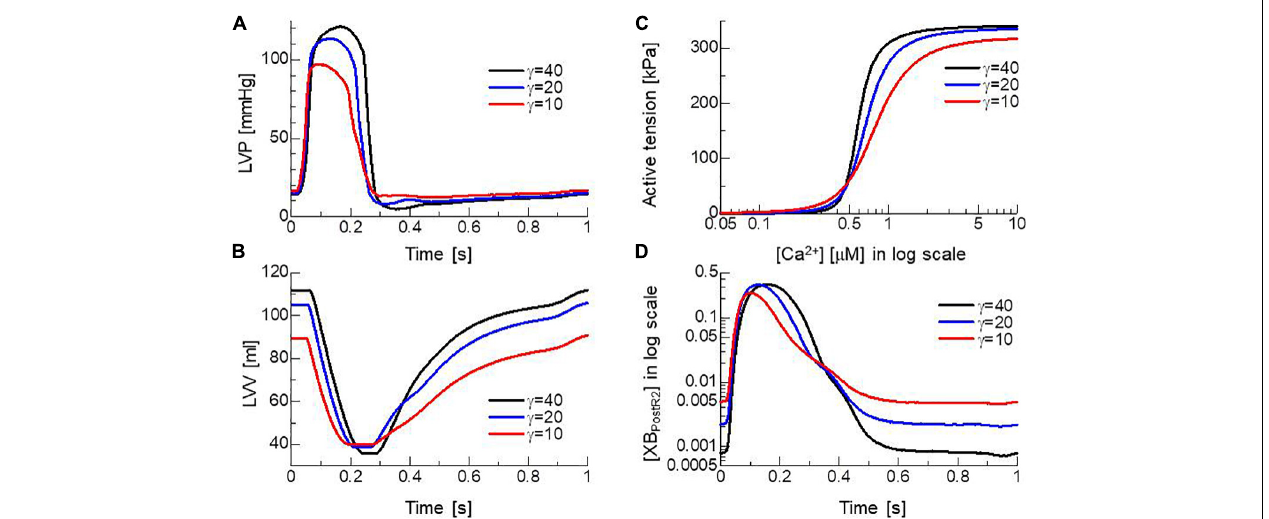
FIGURE 9 | Effects of the nearest neighbor co-operative parameter γ on the time transients of (A) left ventricular pressure (LVP), (B) volume (LVV), (C) the force-pCa relationship under the unloaded sarcomere length, and (D) time transient of state ratio [XB PostR 2 ] in the logarithmic scale. The black, blue, and red lines indicate γ = 40, 20, and 10, respectively.